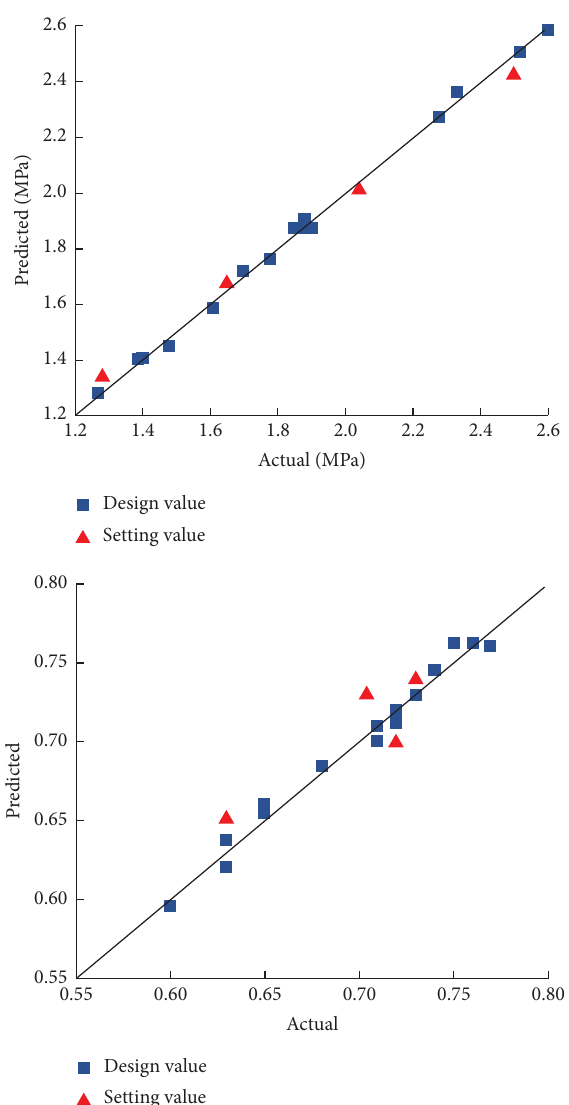
Figure 4: Distribution graphs of the predicted numeral values and the actual numeral values of the response index (unconfned compressive strength and softening